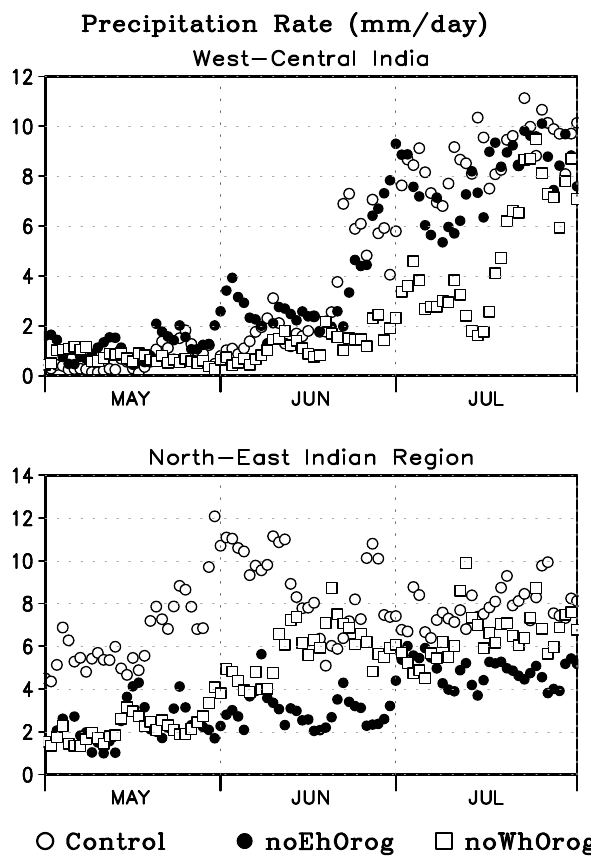
Fig. 10. Evolution of rainfall over (top) West Central India (WCI) and (bottom) North East India (NEI) in the control , noWhOrog and noEhOrog simulations.